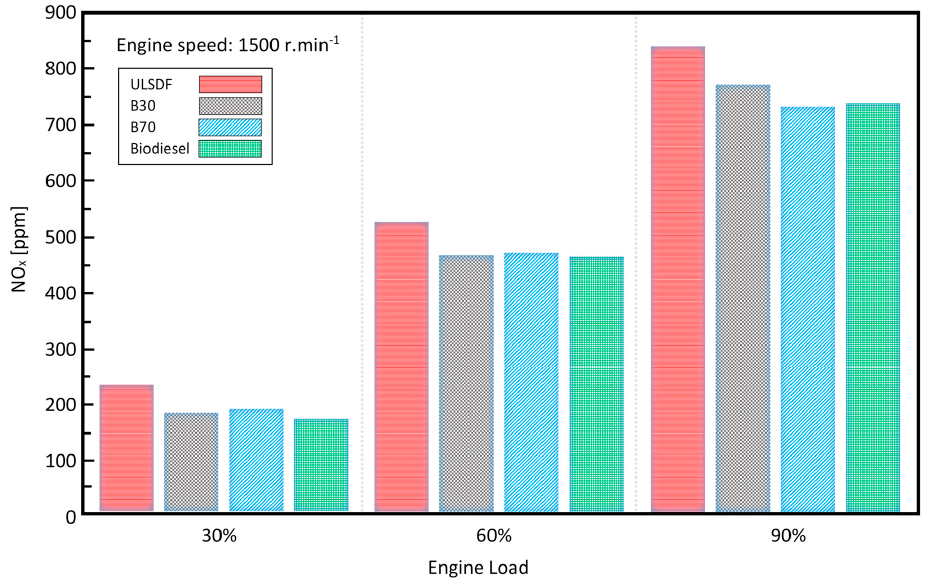
Figure 9. The dependence of testing fuels on the NOX emissions (1500 rpm).